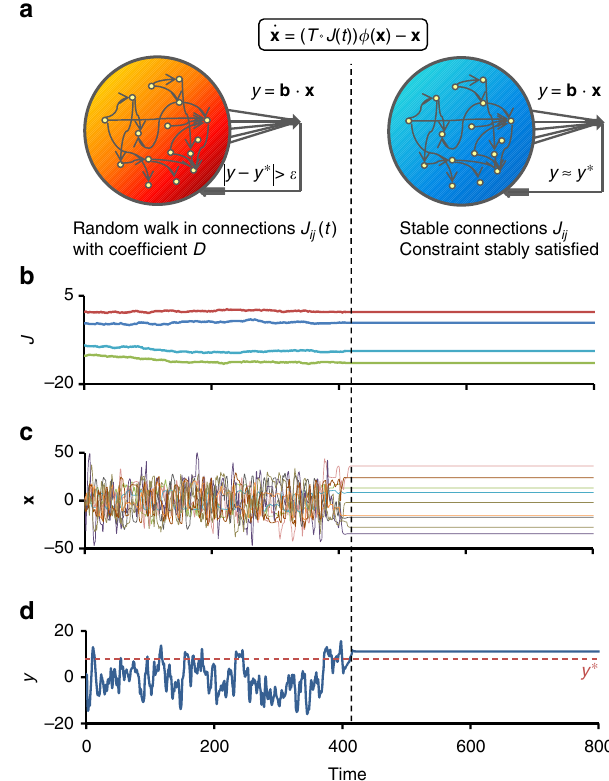
Figure 1 | Exploratory dynamics and convergence to a constraint- satisfying stable state. ( a ) Schematic representation of the model: a random N (cid:4) N network, composed of an adjacency matrix T and an interaction strength matrix J , governs a nonlinear dynamical system (equation in box; f ( x ) ¼ tanh( x )). The resulting spontaneous dynamics are typically irregular for large enough interactions. A macroscopic variable, the phenotype y , is subject to an arbitrary constraint y E y (cid:5) with finite precision e . When the constraint is not met (left; ‘hot’ regime), the connections strengths J ij undergo a random walk with magnitude determined by the coefficient D and the mismatch function M ( y (cid:2) y (cid:5) ). The random walk stops when the mismatch is stably reduced to zero (right; ‘frozen’ regime). ( b – d ) Example of exploration and convergence. Shown are representative trajectories of connection strengths ( b ), microscopic variables ( c ) and the phenotype y ( d ) before and after convergence to a stable state satisfying the constraint. The network in this example has scale-free (SF) out-degree distribution ( a ¼ 1, g ¼ 2.4) and Binomial in-degree distribution p ’ 3 : 5 ; N (cid:2) (cid:3) . N ¼ 1,000, y (cid:5) ¼ 10, D ¼ 10 (cid:2) 3 , g 0 ¼ 10. N See Methods for more